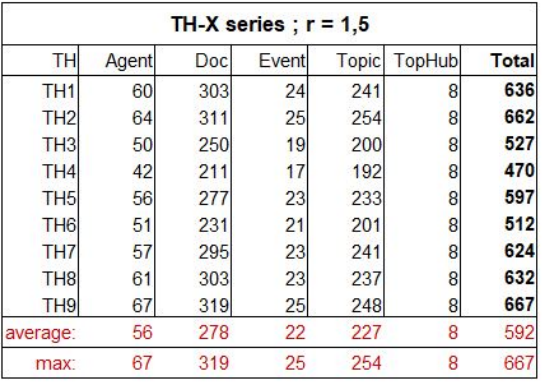
Figure 8. The resources collected in TH-X series.